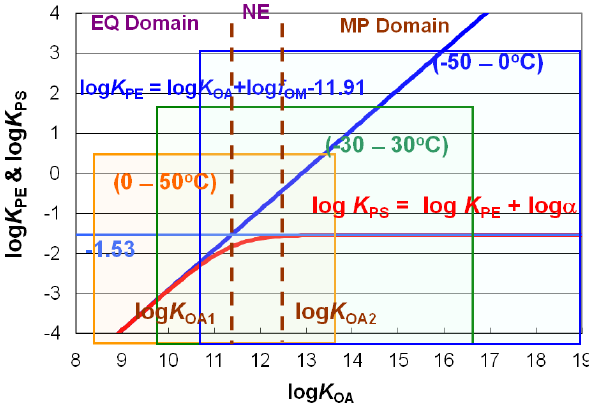
Figure 1. Variation of log K PE and log K PS as functions of log K OA with a temperature range of − 50 to + 50 ◦ C. Two threshold values of log K OA (log K OA1 and log K OA2 ) are also shown, which divide the space of log K OA into three domains: the equilibrium (EQ), the non-equilibrium (NE), and the maximum partition (MP) domains. The three squares designate the log K P –log K OA graphs with three different temperature ranges: 0 to + 50 ◦ C, − 30 to + 30 ◦ C, and − 50 to 0 ◦ C, representing the tropical and subtropical climate zones, warm temperate climate zone, and boreal and tundra climate zones,